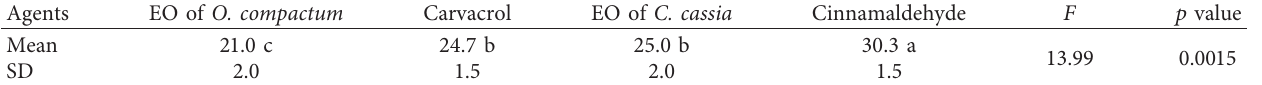
Table 3: Diameters (mm) of the zones of inhibition obtained with the reference strain Salmonella CTP 8059 . Agents EO of O.